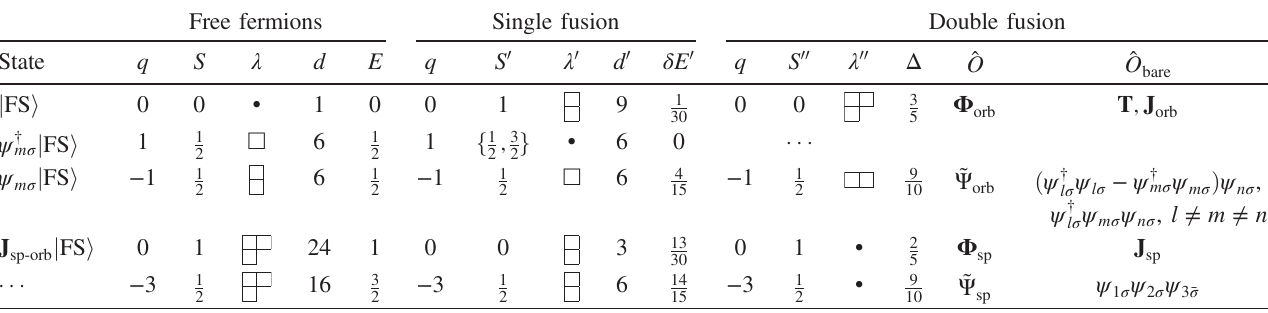
TABLE I. Left: Five low-lying free-fermion multiplets ( j FS i denotes the Fermi sea), with quantum numbers ð q; S; λ Þ , multiplet dimensions d , and energies E ð q; S; λ Þ . Center: “ Single fusion ” with an impurity leads to multiplets with quantum numbers ð q; S 0 ; λ 0 Þ , dimensions d 0 , eigenenergies E 0 ¼ E ð q; S; λ 0 Þ , and excitation energies δ E 0 ¼ E 0 − E 0 which fuses multiplets from the middle column with an impurity in the conjugate representation on (C3)], yields the multiplets ð q; S 00 ; λ 00 Þ . These characterize the CFT boundary operators Φ and Φ are the leading boundary operators in the orbital and spin sectors, respectively. In the spin-splitting regime, their roles are orb sp ˜ Ψ ˜ Ψ taken by and , respectively. “ Bare ” free-fermion versions of these boundary operators, having the same quantum numbers, are orb sp listed on the very right. For clarity, not all possible multiplets arising from single and double fusion are shown. A more comprehensive list is given in Table